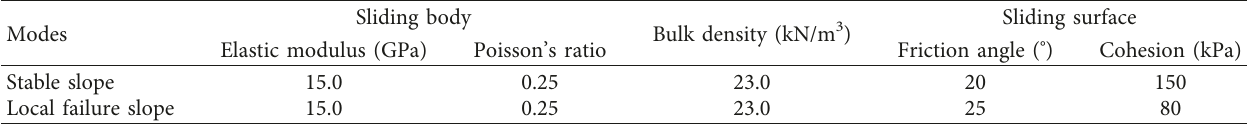
Table 10: Influence of elastic modulus and Poisson’s ratio of the sliding bed on safety factors and error range. Modes Schemes Stable